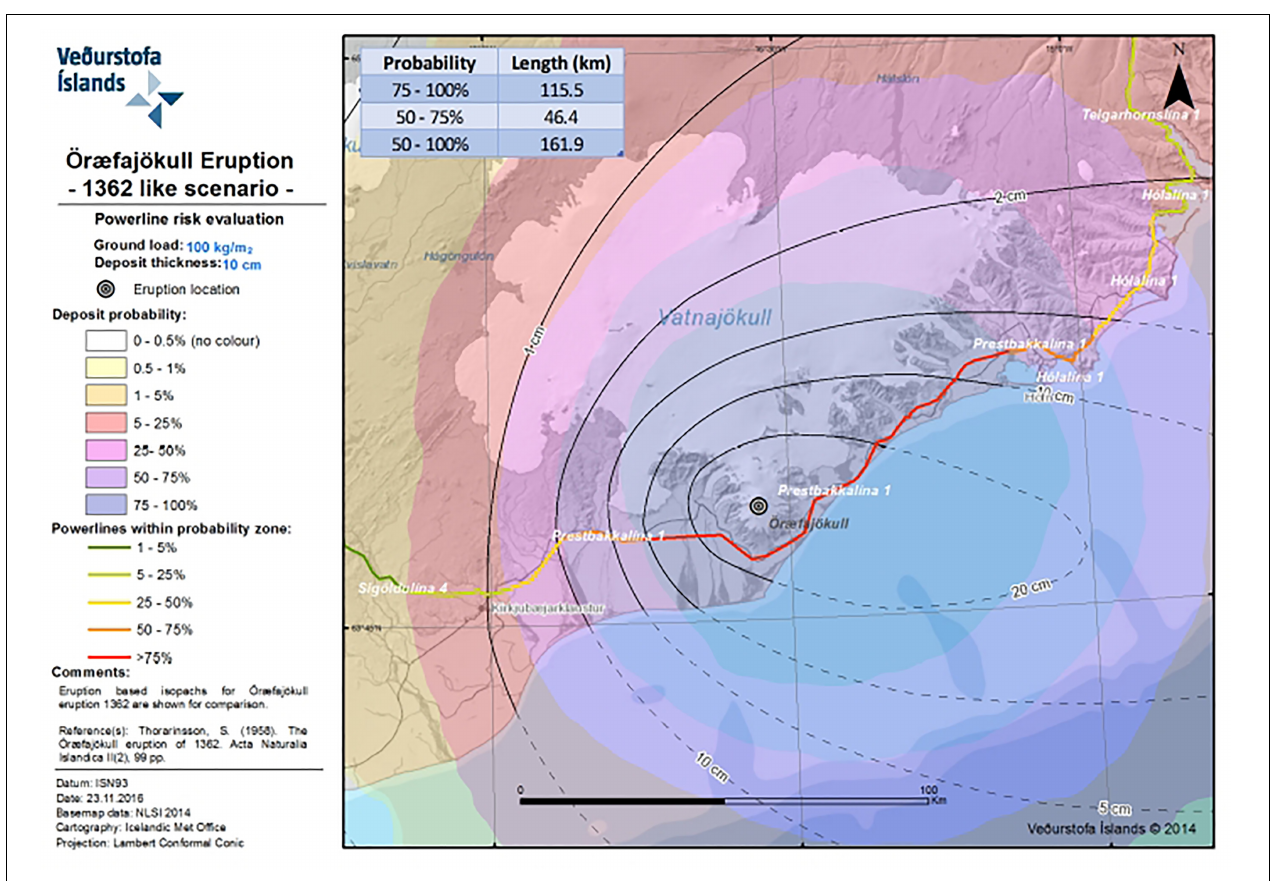
FIGURE 11 | Map showing potential tephra fallout impact to power-lines in case of a 1362-like eruption at